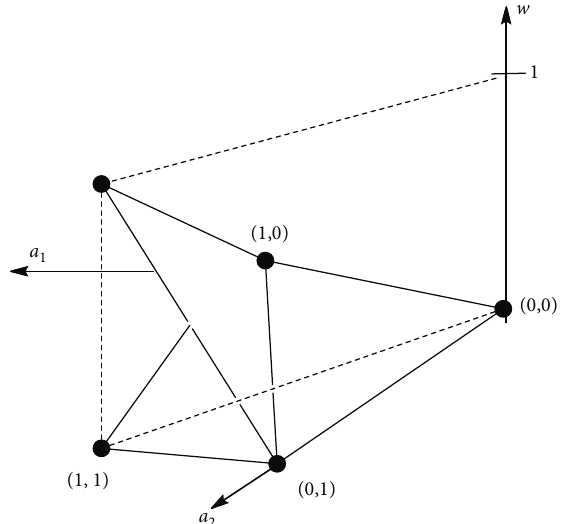
Figure 2: Polyhedral homeopathy proposed